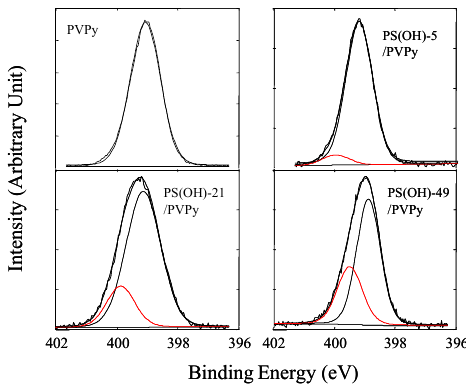
Figure 10. XPS N1s core-level spectra of pure PVPy, the PS(OH)-5/PVPy blend, and the PS(OH)-21/PVPy and PS(OH)-49/PVPy complexes [21].